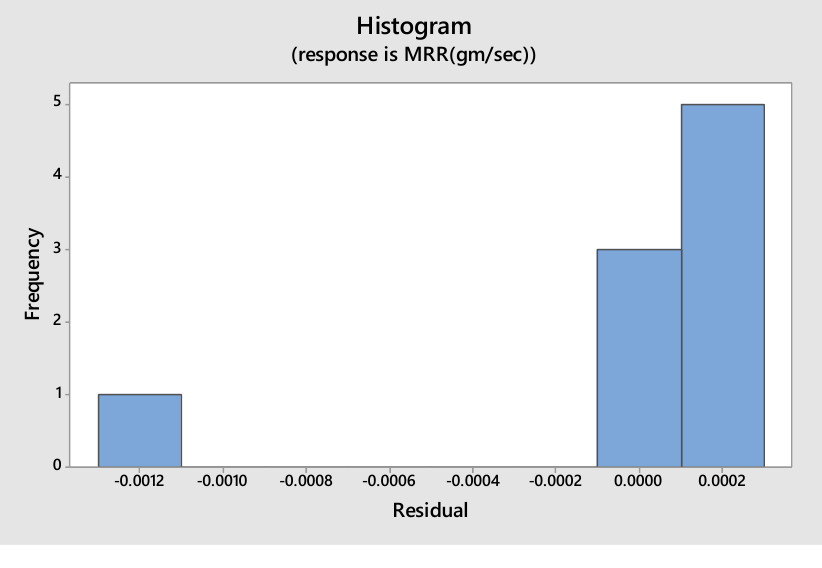
Fig. 2. Histogram for MRR